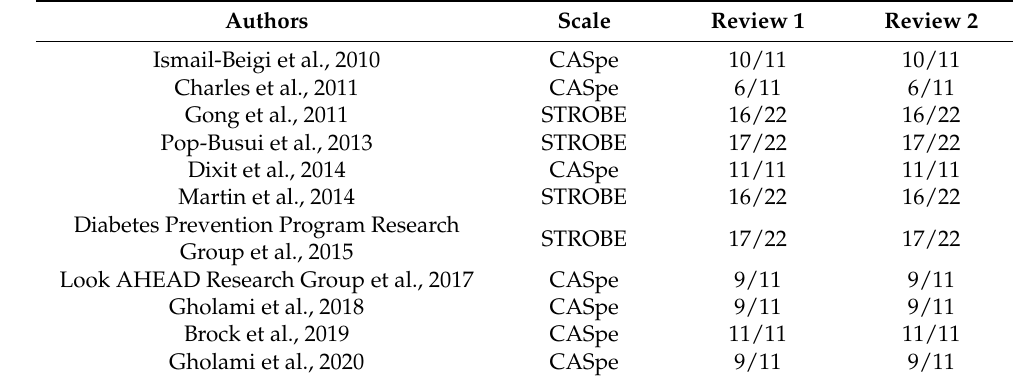
Table 3. Scores of the investigators on the quality scales of the included